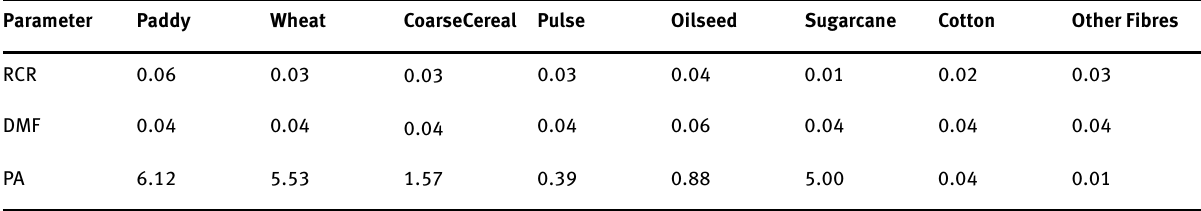
Table 2: Standard uncertainties (u) in the various conversion factors (that are major contributors to uncertainties) for different crop